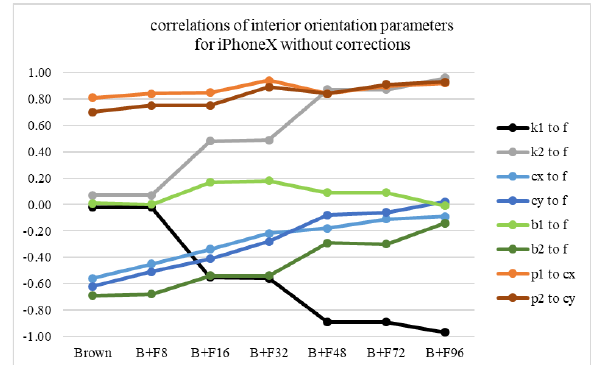
Figure 8. Residual plots from Agisoft Metashape with B and B+F96 for iPhoneX (data set 7); vector scale 100.